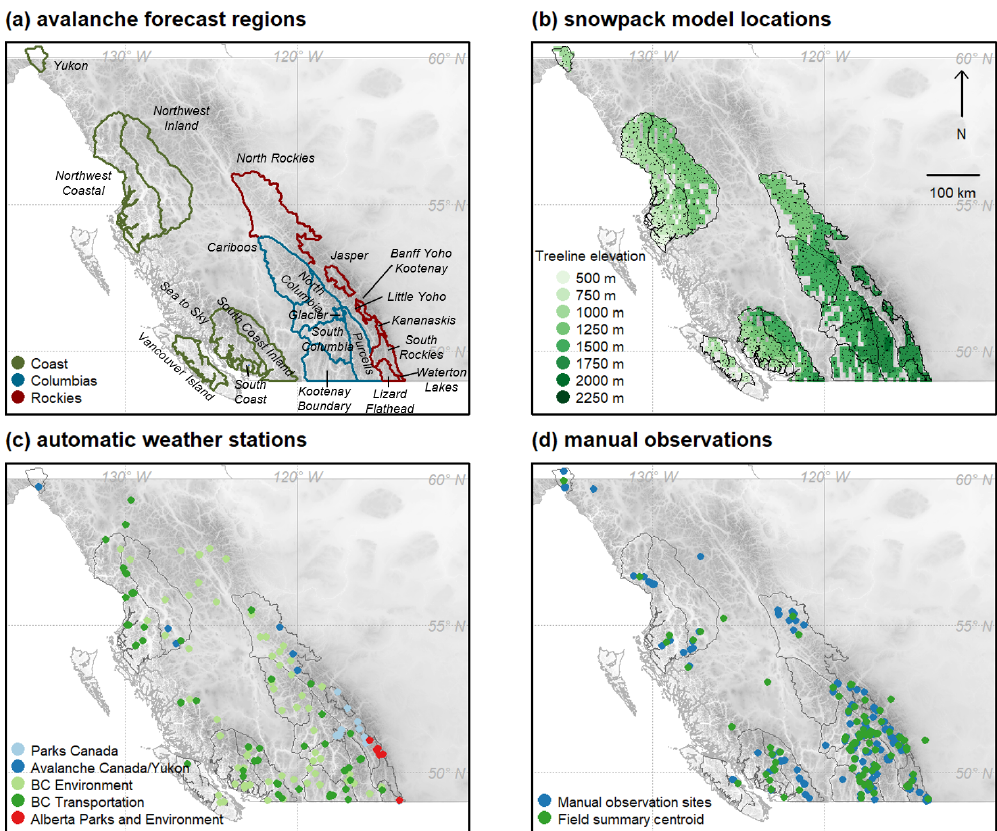
Figure 1. Location of (a) avalanche forecast regions, (b) snowpack model grid points for each 10km × 10km grid cell colour-coded by local treeline elevation, (c) automatic weather stations, and (d) manual observations and field